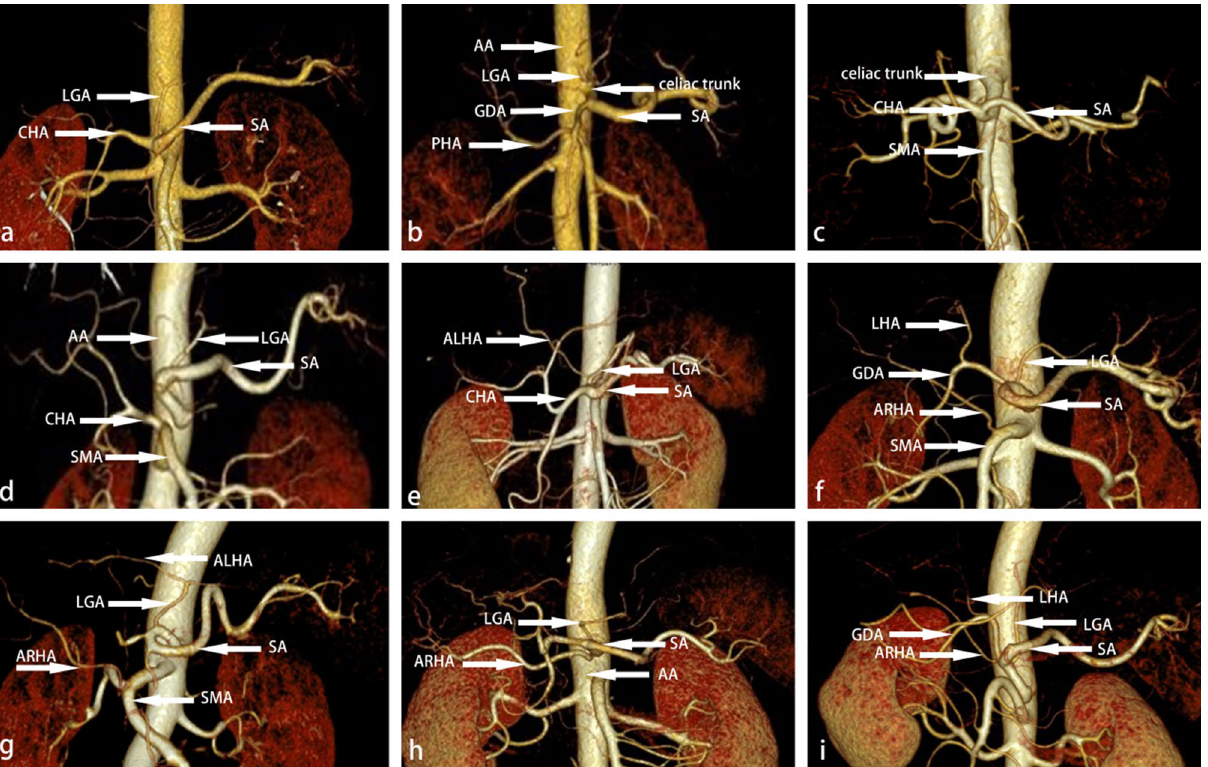
Figure 3. Classification of the celiac trunk. ( a ) LGA, CHA, and SA all originated from the celiac trunk. ( b ) LGA originated from AA, CHA and SA originated from the celiac trunk. ( c ) CHA, SA, SMA, and LGA originated from the celiac trunk. ( d ) CHA originated from SMA. ( e ) ALHA from LGA. ( f ) The ARHA originated from SMA. ( g ) ARHA from SMA, ALHA from LGA coexist. ( h ) In this case, ARHA from AA. ( i ) In this case, ARHA from the celiac trunk.